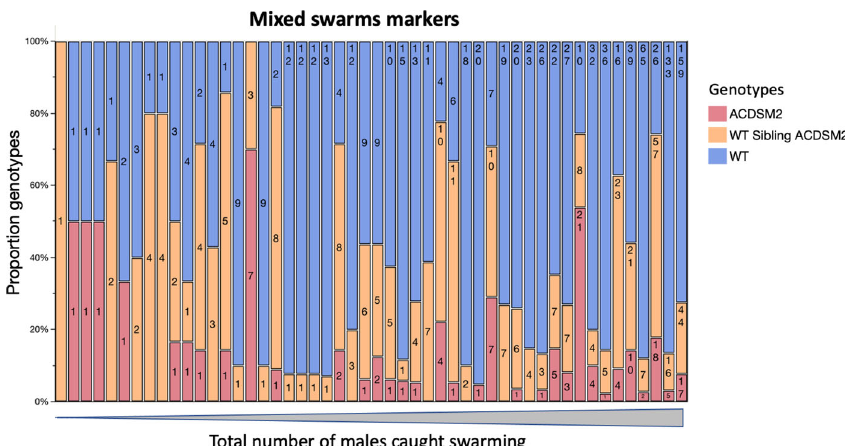
Fig. 5 The proportion of marked males of each genotype and wild unmarked males captured over markers where mixed swarms were found. Each bar represents one swarm marker. Mixed swarm markers are sorted left to right by increasing total number of males captured over each marker over 20 days, which ranged from 1 (left) to 220 (right). Bar labels describe the total number of males of each genotype collected. (ACDSM2: Anopheles coluzzii Dominant Sterile Male; WT sibling ACDSM2: Wild type sibling Anopheles coluzzii Dominant Sterile Male; WT: Wild Type). Table 3 Bayesian posterior percentiles of population size, survival and diffusion, inferred from the swarm recapture data. Parameter